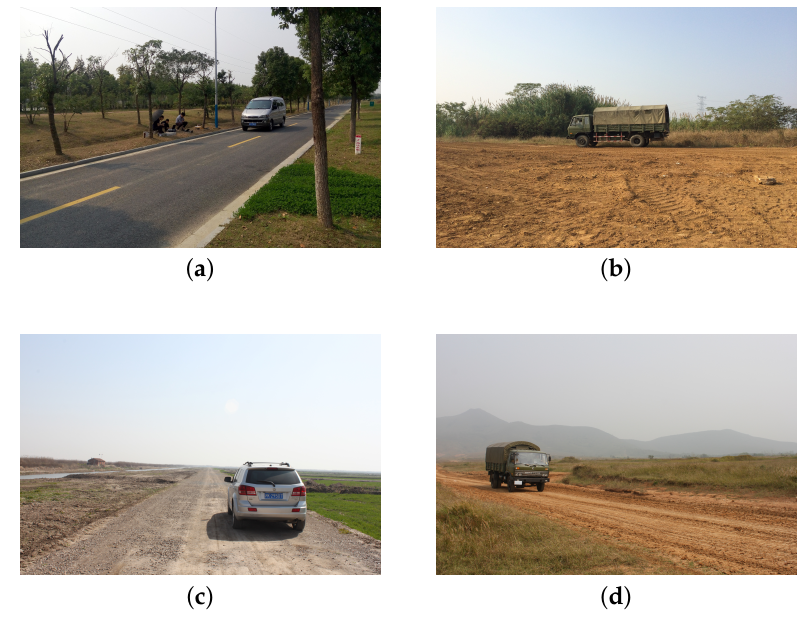
Figure 4. Four different experimental environments in the wild. ( a ) Cement road; ( b ) Dirt road; ( c ) Gravel road; ( d ) Mud road.